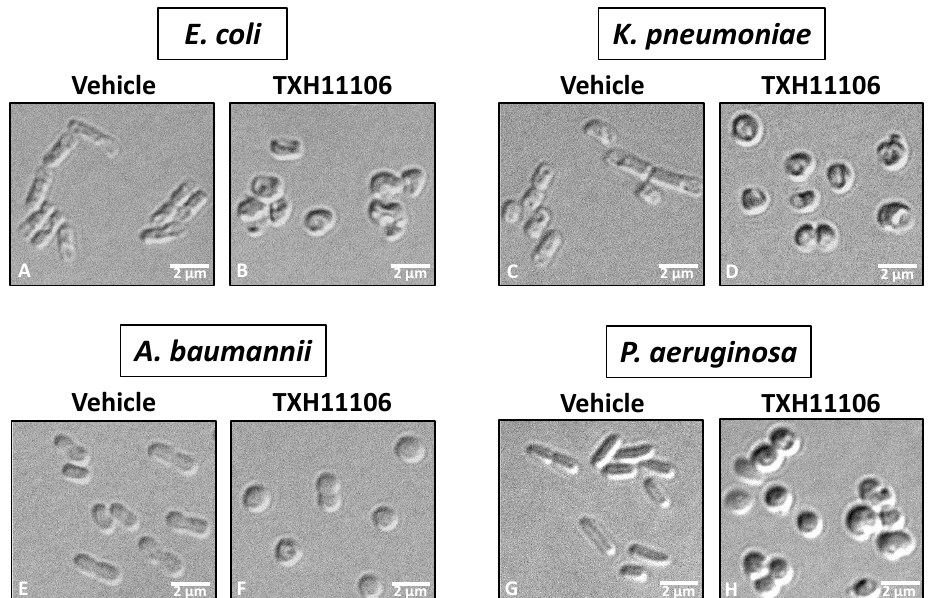
Figure 3. Differential interference contrast (DIC) micrographs of E. coli 25922 ( A , B ), K. pneumoniae 13883 ( C , D ), A. baumannii 19606 ( E , F ), and P. aeruginosa 27853 ( G , H ) treated for 3 h with DMSO vehicle ( A , C , E , G ) or TXH11106 at 1× MIC ( B , D , F , H ). The scale bars reflect 2 µm in length. E. coli